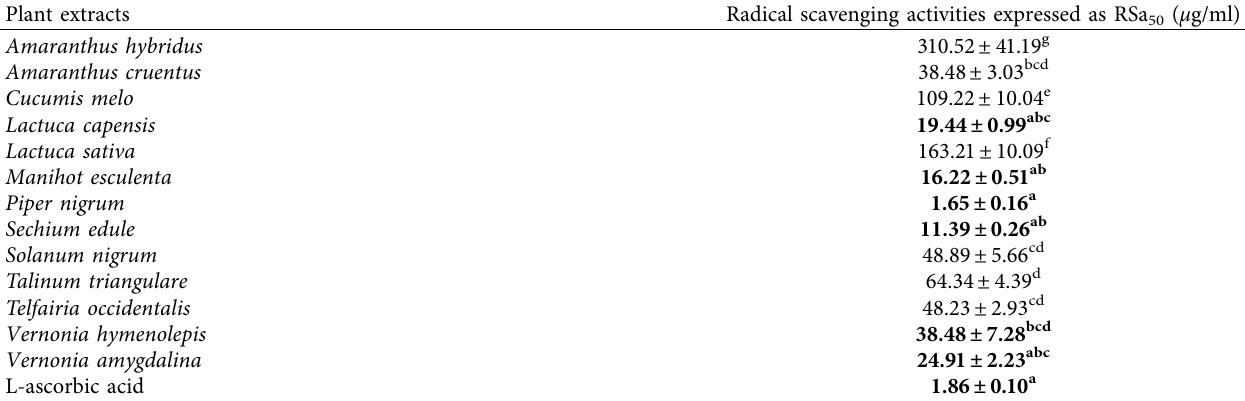
Table 5: DPPH radical scavenging activities of the methanol extracts of thirteen antibacterial edible plants. Plant extracts Radical scavenging activities expressed as RSa 50 ( μ